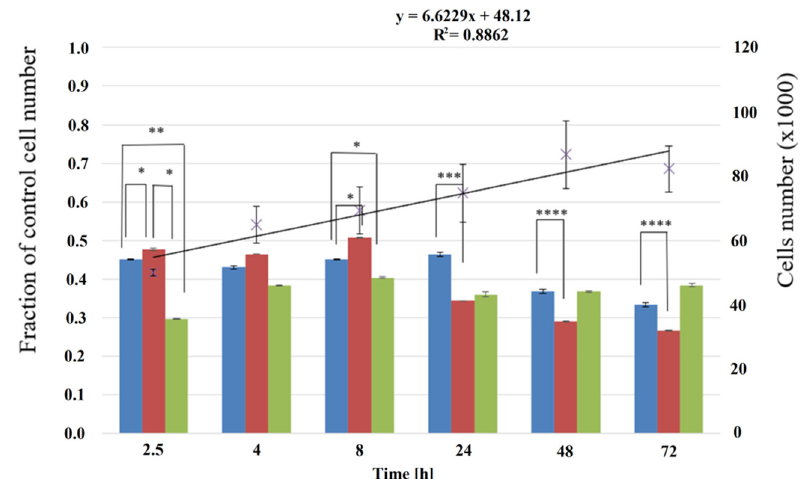
Figure 6. Percentage of fibroblasts cultured on P(iPrOx-nPrOx) films and TCPS. The fraction of control cells and cell numbers were assayed from 2.5 to 8 h for adhesion and spreading and for proliferation; the assays were conducted after 24, 48, and 72 h. The results for Films 1–3 are shown in blue, red, and green, respectively. The line presents the changes in the number of cells cultured on TCPS from 2.5 to 72 h of the incubation. Statistical analysis was performed using two-tailed Student’s test. Stars indicate p-values: * p < 0.05, ** p < 0.01, *** p < 0.001, **** p < 0.0001. Values are mean ± SD (n = 3).